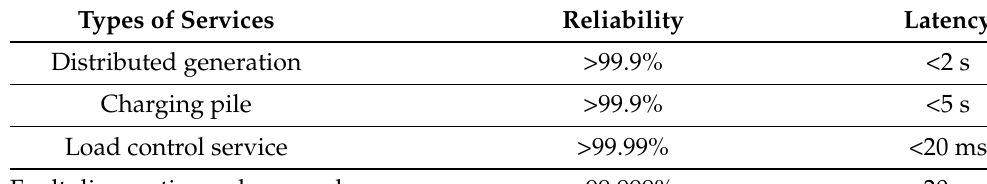
Table 1. The reliability and latency requirements of typical electric power services [19].